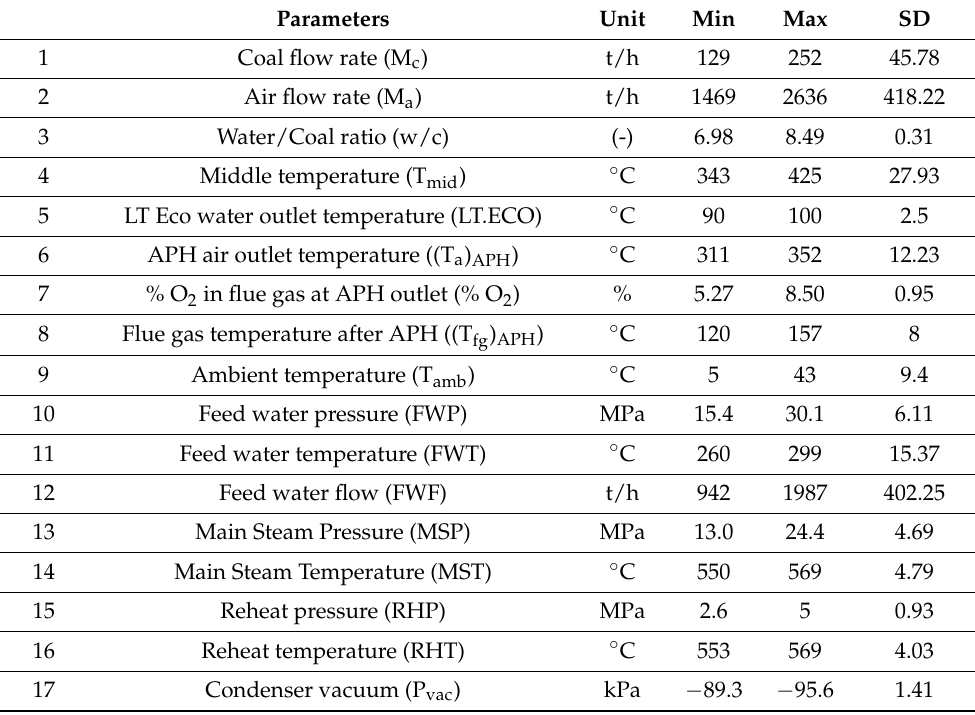
Table 2. Statistics of the training data of input and output